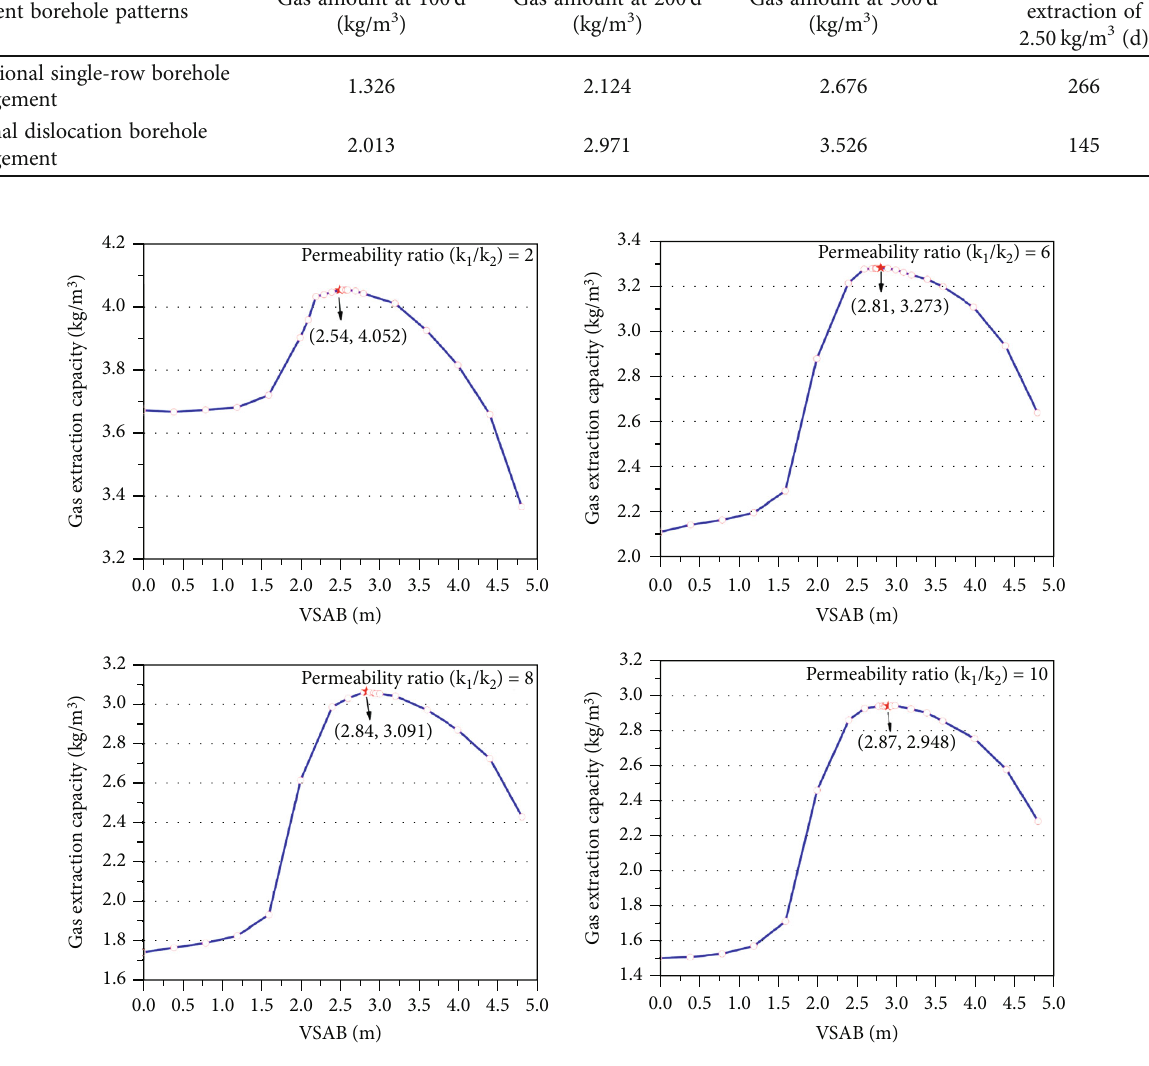
Table 3: Comparison of the gas extraction amount between the traditional and optimal dislocation borehole arrangement. Di ff erent borehole